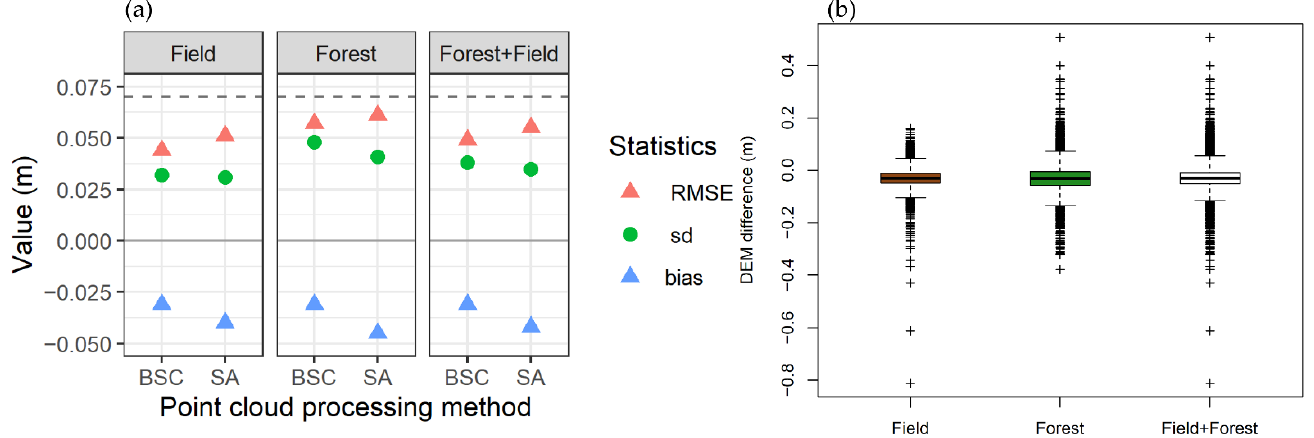
Figure 9. ( a ) Relative error statistics from repeat flights in field, forest, and the combined landscape for the two point cloud processing methods; ( b ) relative error distribution in field, forest, and the combined landscape of the BSC data.